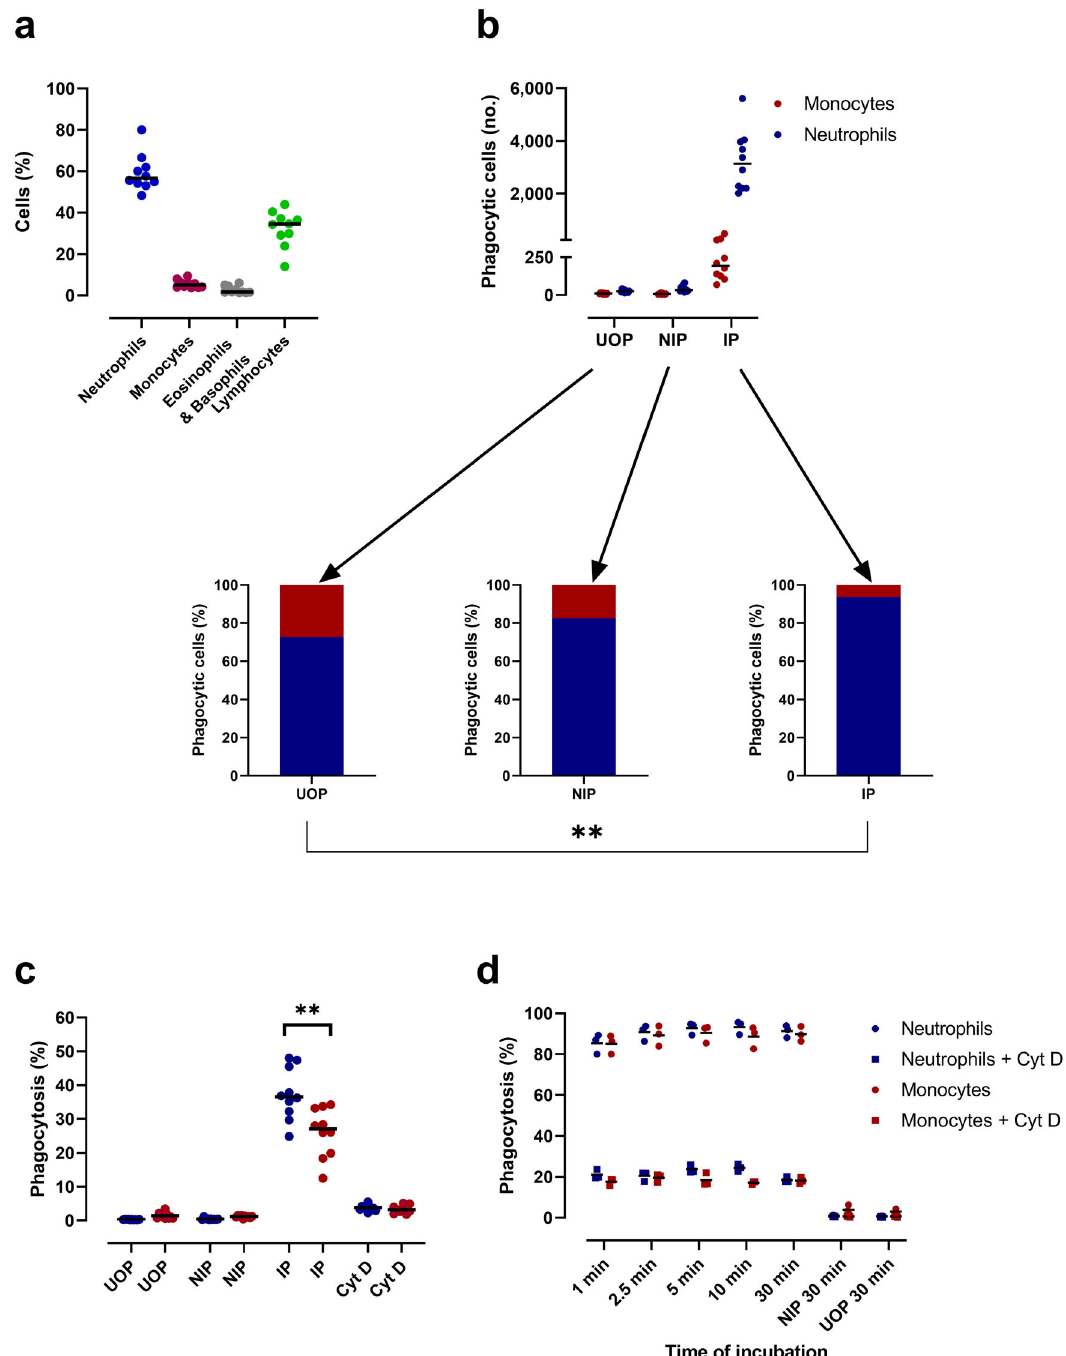
Fig. 1 Malarial antibodies induce merozoite-phagocytosis by neutrophils and monocytes. a Percentage of individual leukocytes in PBLs from Danish blood donors ( n = 10) was enumerated by fl ow cytometry. Horizontal lines represent median values. b From each donor, 6 × 10 4 PBLs were incubated with unopsonized merozoites (UOP), merozoites opsonized with a pool of nonimmune plasma (NIP), or with immune plasma (IP) for 30 min at 37 °C for phagocytosis to occur. Cells were stained with anti-CD14, CD16, CD45, and CD66b antibodies and analyzed by fl ow cytometry to enumerate ethidium bromide (EtBr)-positive cells. The mean number (no.) of neutrophils (blue) and monocytes (red), which ingested merozoites are shown in the upper panel, and the percent contribution of neutrophils and monocytes to overall PBL phagocytosis is shown in lower panels for the given opsonized/unopsonized condition. c Mean percentage of monocytes or neutrophils in PBL preparations that phagocytosed merozoites in the presence of NIP, IP, or UOP condition. The percent phagocytosis of IP-opsonized merozoites is also shown for cytochalasin D (Cyt D) treated PLBs. d Kinetics of IP-opsonized merozoite uptake by monocytes and neutrophils present in Cyt D pretreated or untreated PBLs. Phagocytosis was stopped at indicated time points, and percent phagocytosis by the neutrophils and monocytes is expressed as the mean of triplicates. Data are represented from one of the two independent assays. Results were obtained with PBLs from 10 different Danish blood donors ( a – c ). P values were determined by Wilcoxon signed-rank test b and c . Asterisks represent P values (** P <